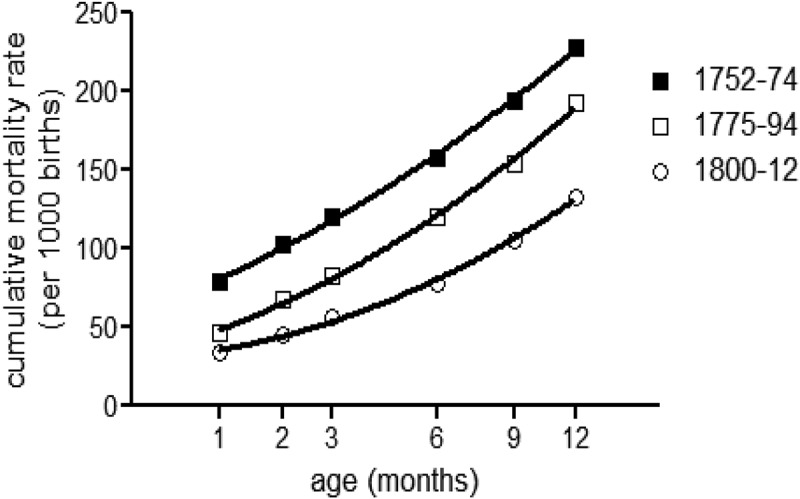
Unadjusted cumulative mortality over the first year of life.
Notes: Curves fitted with second order polynomial equations to estimate endogenous mortality. Note log transformation of x-axis.Source: St. Martin in the Fields family reconstitution.